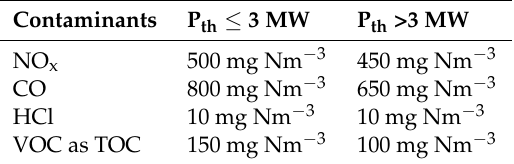
Table 1. Legal limits for biogas plants set in the Legislative Decree No. 152 of 3 April 2006 [83].